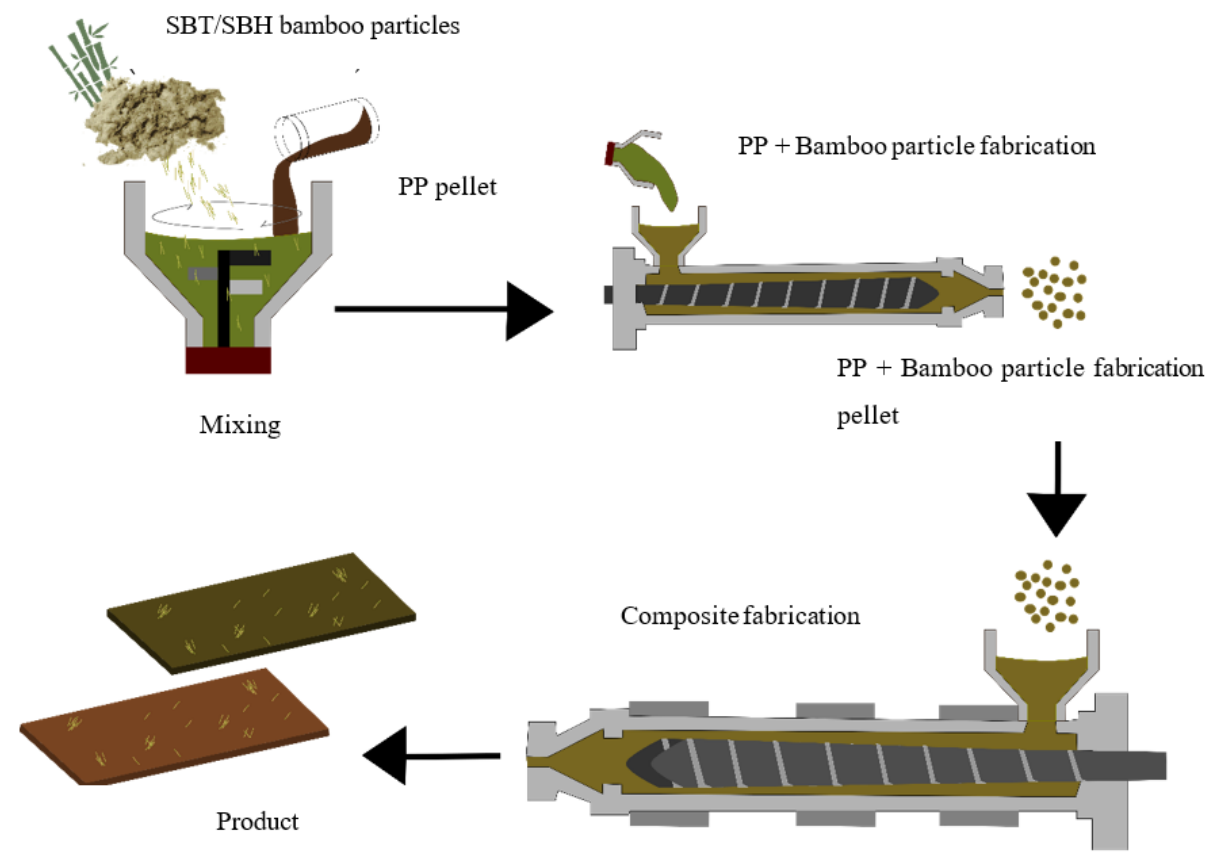
Figure 2. BPRPP Composite Fabrication Process. Table 1. Composite fabrication and characterization process